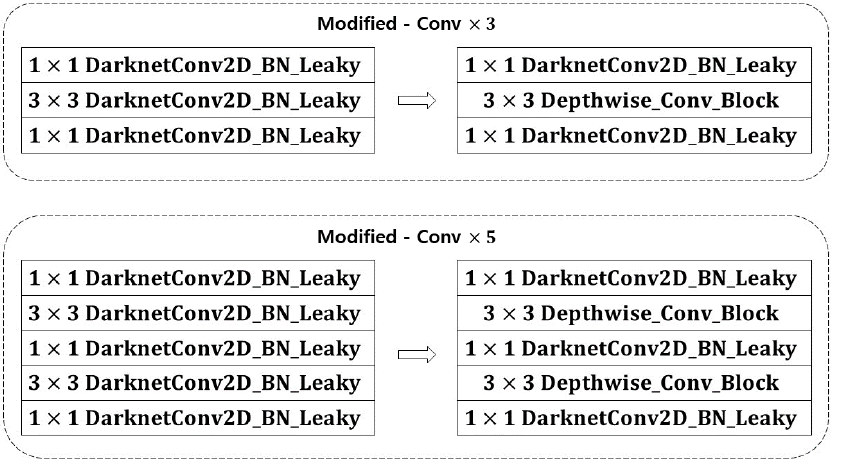
Figure 9. The depthwise separable convolutions are used to replace the standard convolutions in SPP and PANet.